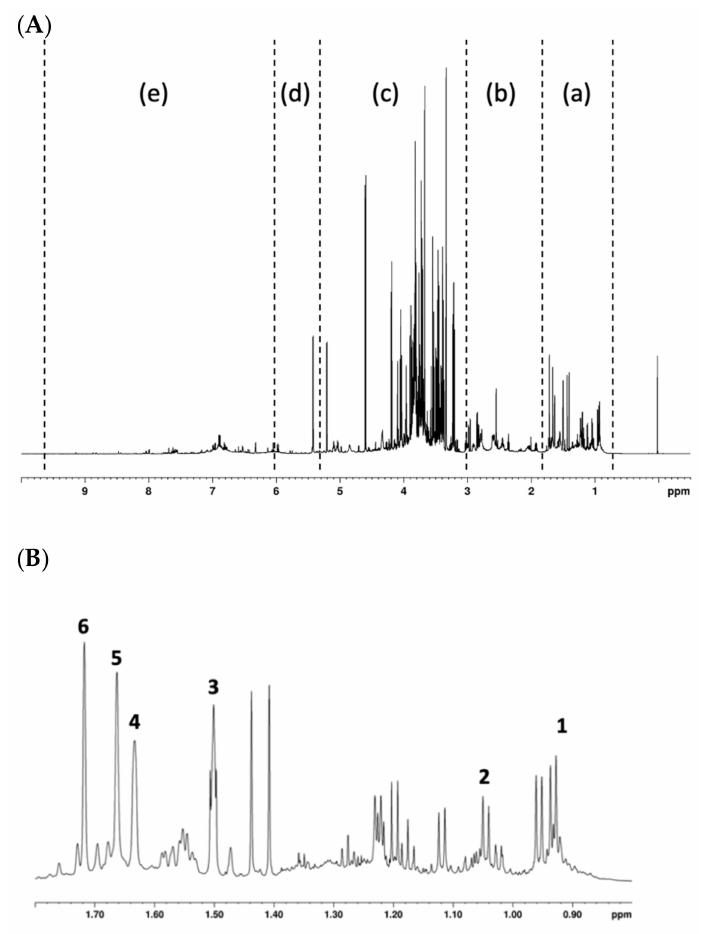
Figure 1. The 1 H NMR spectrum of hop extract. Section ( A ): (a) hop bitter acids region from 0.5 to 1.8 ppm; (b) aliphatic region from 1.8 to 3 ppm; (c) sugars from 3.0 to 5.5 ppm; (d) terpenes from 5.5 to 6.0 ppm; and (e) aromatics from 6.0 to 9.5 ppm. Section ( B ): the enlargement of the bitter acids region is shown in this section with the assigned signals of humulone (1, 3–6) and cohumulone